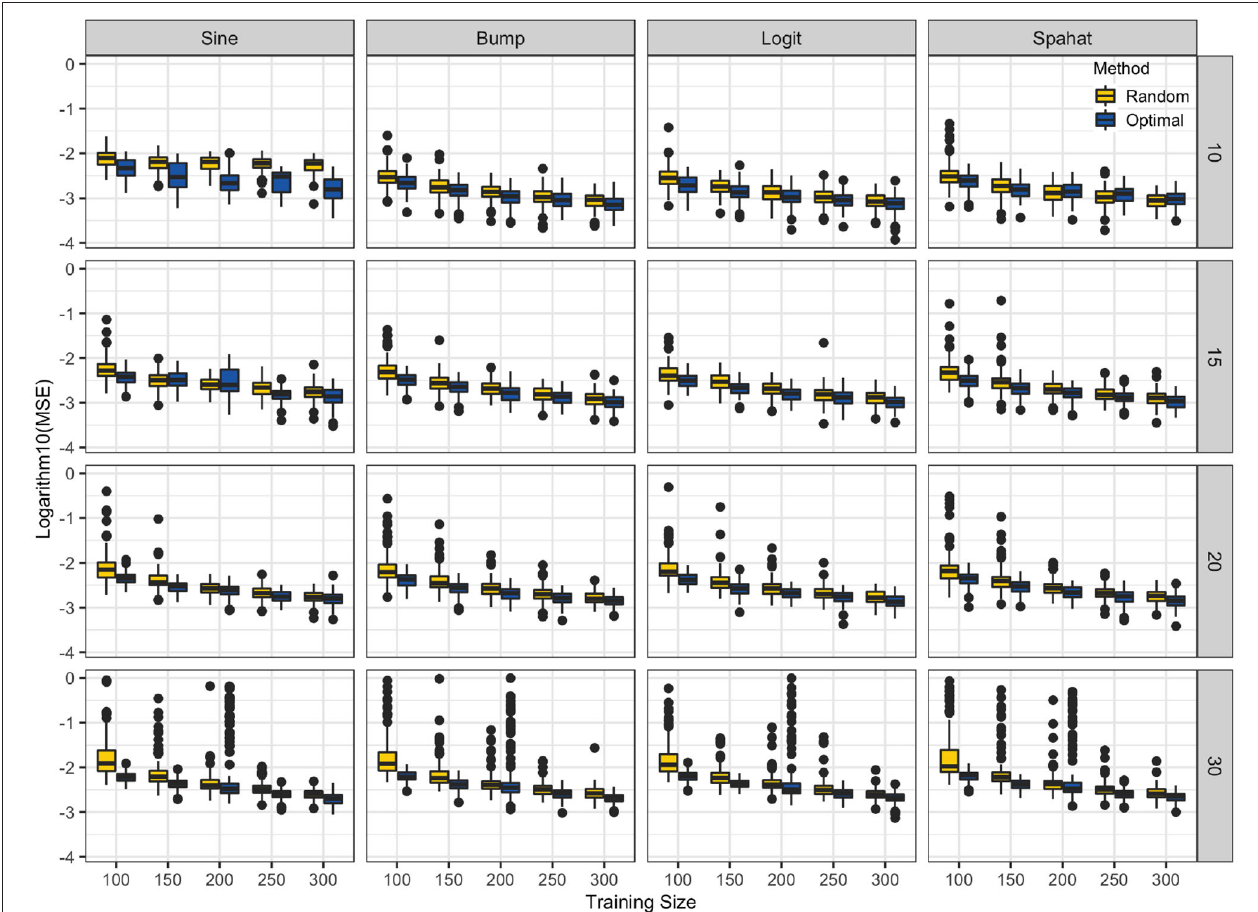
FIGURE 5 | TrainSel spline application. The logarithm of the mean square errors (y-axis) splines models trained on random samples with knots (10, 15, 20, and 30) located at equally spaced sample quantiles. Optimal training size (x-axis) and knots were selected by optimizing the D-optimality criterion for the different number of knots and different sample sizes for a set of functions. At each combination of sample size and the number of knots mean squared errors are lower for the latter approach. Although, in very few cases random sample performed slightly better than the optimized samples, the general trend is in favor of the optimized approach.